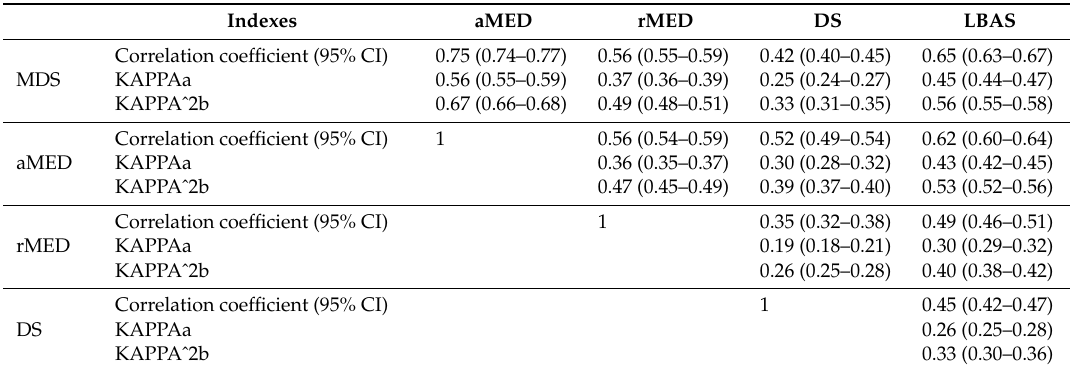
Table 4. Reliability among the indexes of adherence to the Mediterranean diet pattern (three categories: low, medium and high